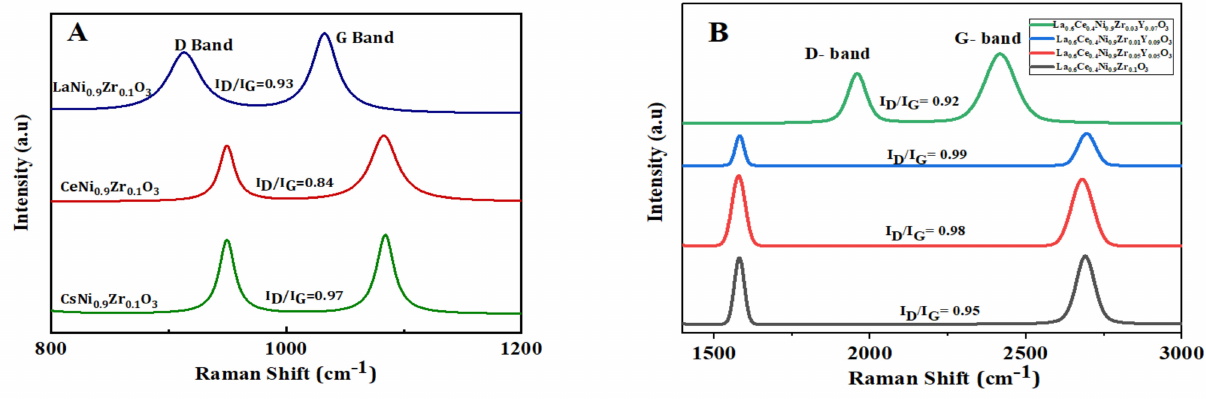
Figure 14. Raman spectra of used catalyst: ( A ) MNi 0.9 Zr 0.1 O 3 (M = La, Ce and Cs); ( B ) La 0.6 Ce 0.4 Ni 0.9 Zr 0.1 − x Y x O 3 (x = 0.05, 0.07, and